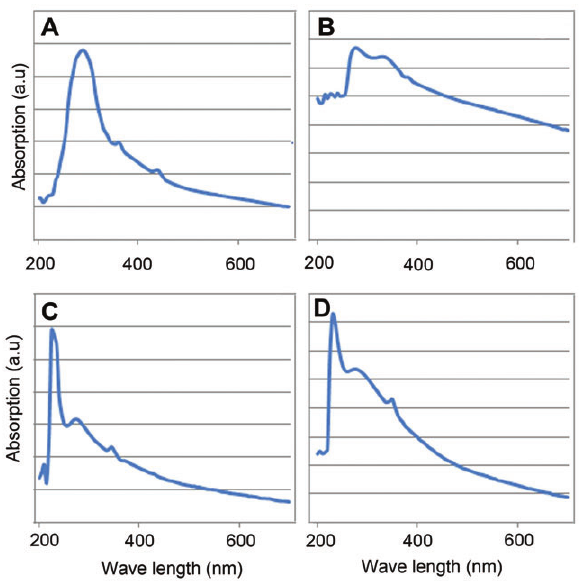
Figure 5 UV-Visible absorption spectra of the PbS nanocrystals